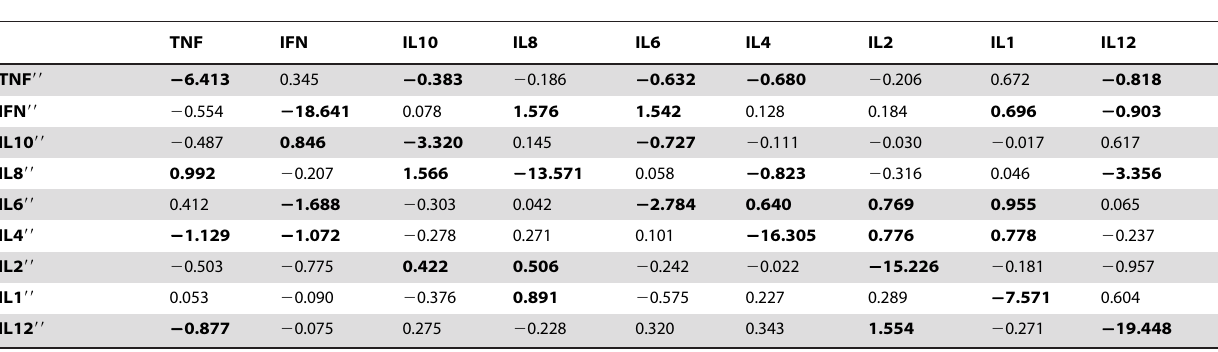
Table 2. Concentration Coefficients of the Fully Coupled Cytokine Model, C C